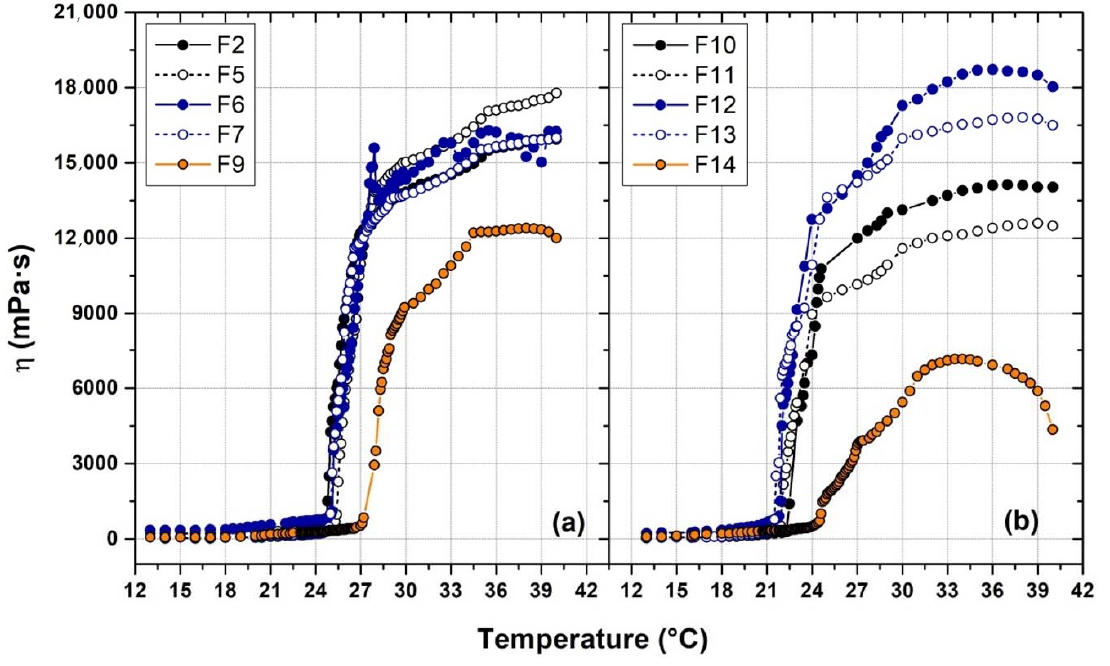
Figure 4. Viscosity profile of formulation prepared in water ( a ) and in PBS 1 × ( b ) at different holding temperature. The solid lines are a trend curves inserted for easy viewing. Table 4. T sol-gel range measured by